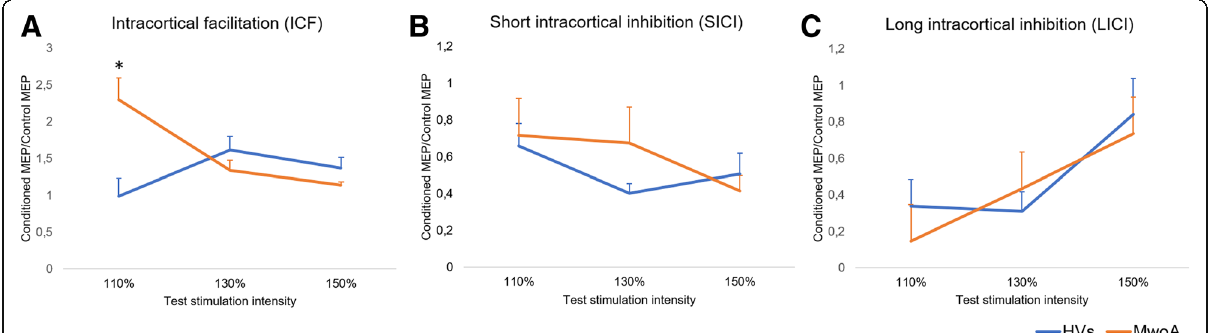
Fig. 1 Electrophysiological measures by paired-pulse TMS recorded from migraine without aura (MwoA) patients and healthy volunteers (HVs) after stimulation of the left primary motor cortex. a Mean values of intracortical facilitation (ICF) determined as the ratio of the average amplitude of the conditioned MEPs to the average amplitude of unconditioned test MEPs. *Significant variation ( p = .014) compared to values recorded in the HVs. b and ( c ) Mean values of short intracortical inhibition (SICI) and long intracortical inhibition (LICI) determined as the ratio of the average amplitude of conditioned MEPs to the average amplitude of unconditioned test MEPs. Error bars indicate standard errors of means